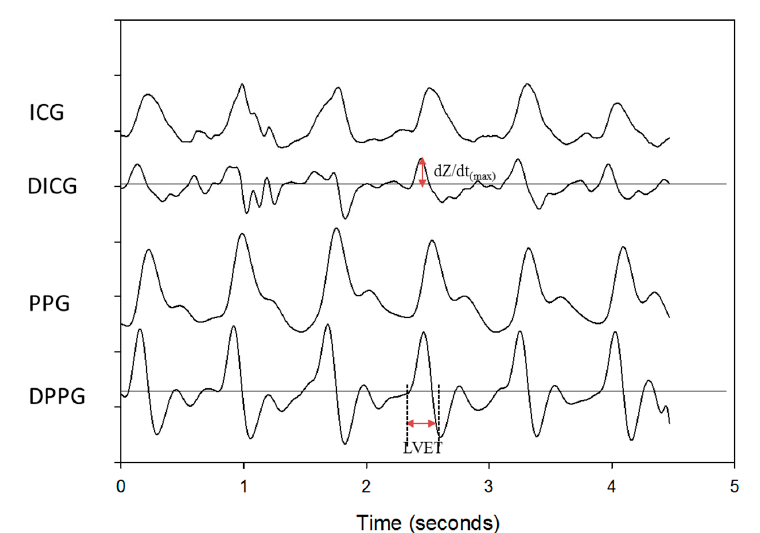
Figure 1. Four signals include impedance cardiography (ICG), differential ICG, photoplethysmography (PPG), and differential PPG. The left ventricular ejection time (LVET) is defined from the differential PPG signal.